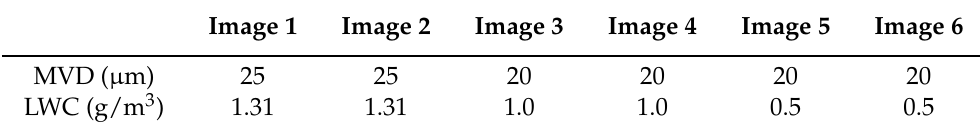
Table 1. Display of MVD and LWC values for some icing wind tunnel